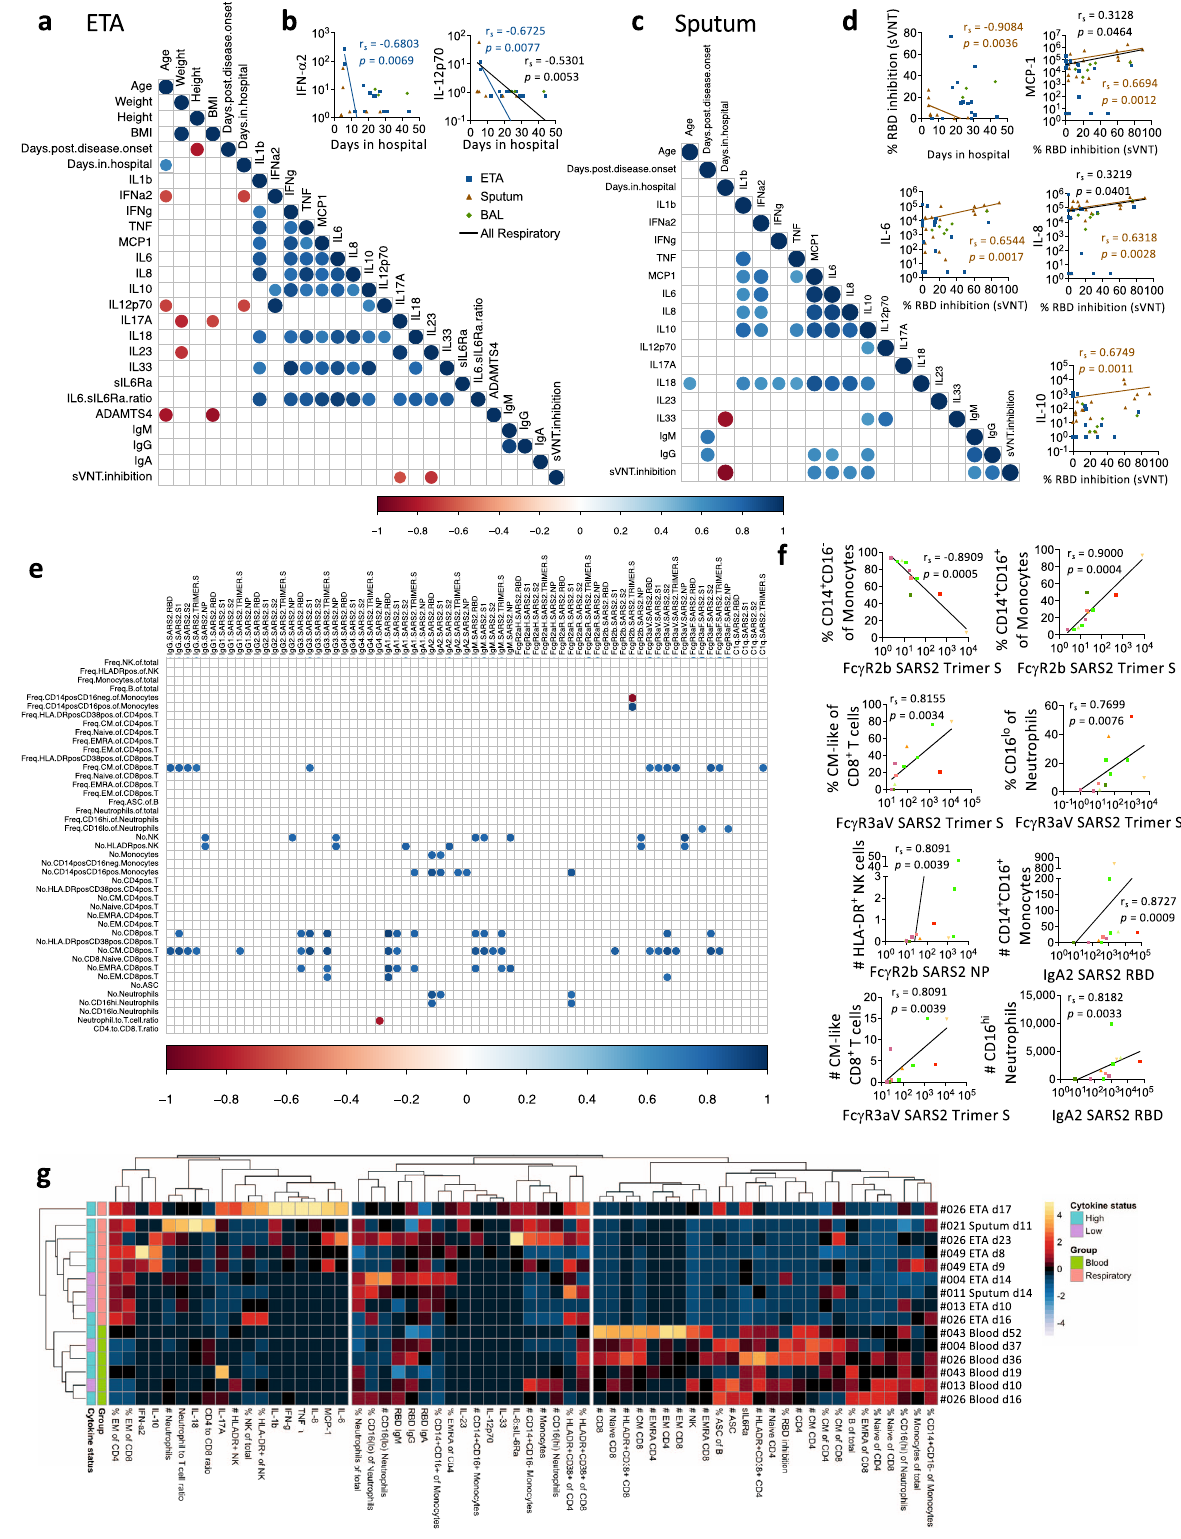
Fig. 6 Levels of ETA IFN-a2 and IL-12p70 and sputum neutralizing activity negatively correlate with days of hospital stay. a – d Correlation matrix and correlation graphs between immune features in COVID-19 respiratory (endotracheal tube aspirate (ETA) or sputum) samples and clinical features. n ETA = 15, n Sputum = 20, n BAL = 6. e – f Correlation matrix and graphs between multiplex and non-multiplex immune features in COVID-19 respiratory samples. n COVID-19 ETA = 10, n COVID-19 Sputum = 3, n COVID-19 pleural fl uid = 1. Correlation was determined with a two-tailed Spearman ’ s correlation and p values of the correlation matrix were adjusted with False Discovery Rate adjustment. g Heatmaps with unsupervised clustering of serological and cellular features in COVID-19 respiratory and blood samples. Source data are provided as a Source Data fi